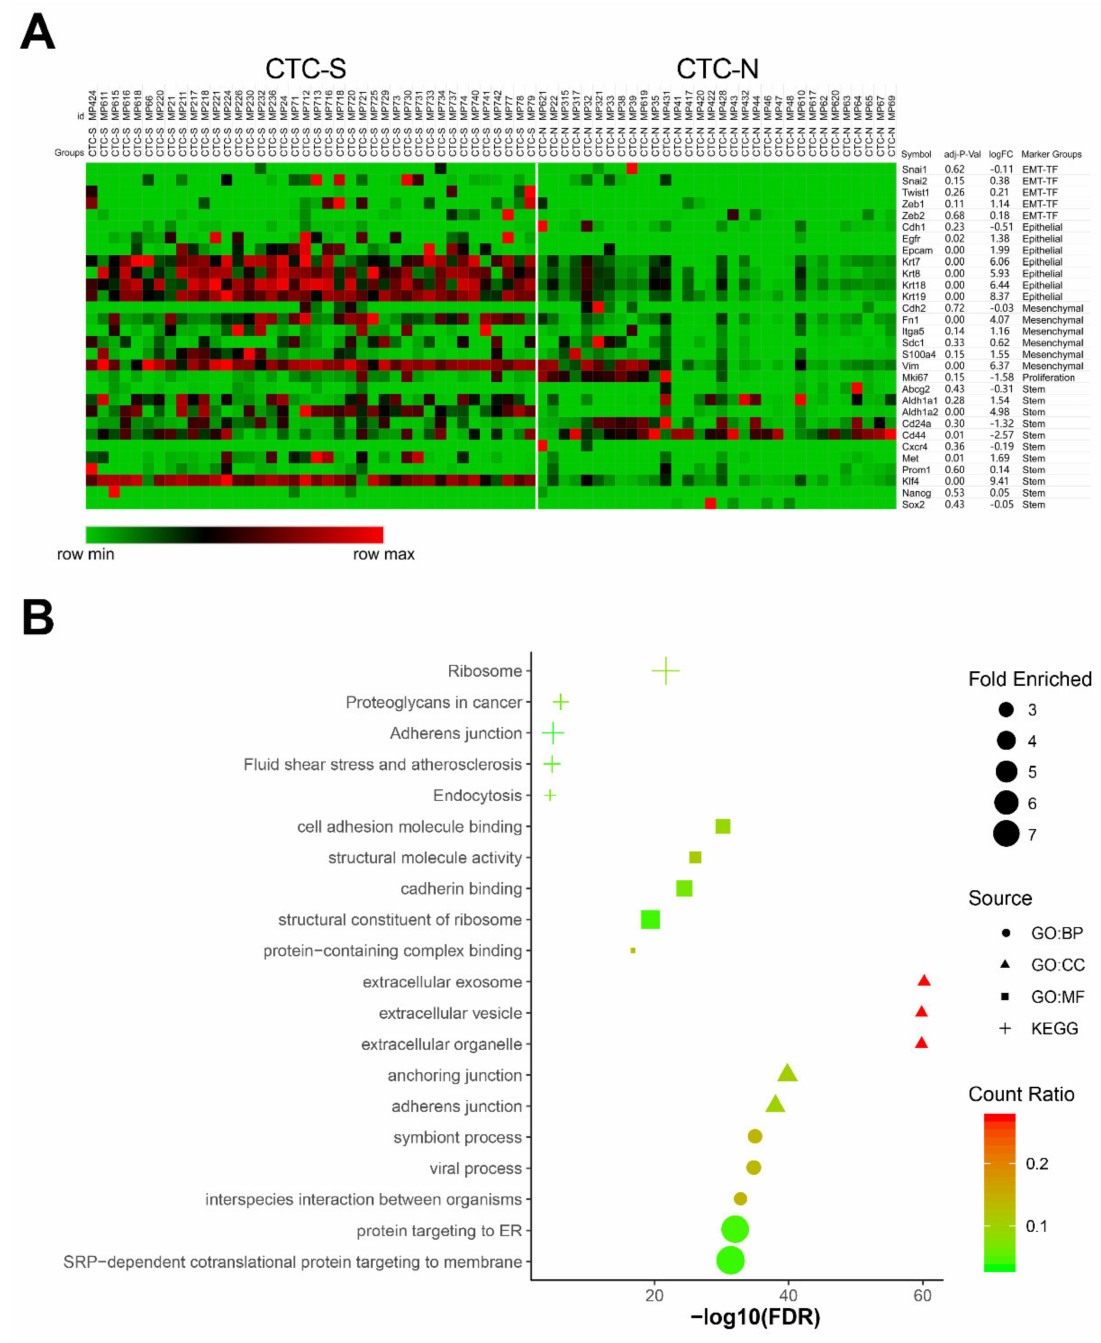
Figure3. Di ff erentiallyexpressedgenesbetweenCTC-SandCTC-Ngroups. ( A )MORPHEUS-generated heatmap showing the expression of the marker set in CTC-S and CTC-N groups. The maximum and the minimum values in each row are displayed red and green, respectively. The marker names, groups, log 2 (FoldChange(FC))values, andfalsediscoveryrate(FDR)valueswerelistedontherightside. ( B )The functional enrichment analysis of up-regulated genes in the CTC-S subgroup was visualized by imageGP (available online: http: // www.ehbio.com / ImageGP / index.php / Home / Index / index.html, 23 April 2020), top 5 enriched Kyoto Encyclopedia of Genes and Genomes (KEGG) pathways, Gene Ontology (GO) terms for biologic processes (BP), cell components (CC) and molecular functions (MF), each aspect was shown (fold enriched > 2 and FDR <